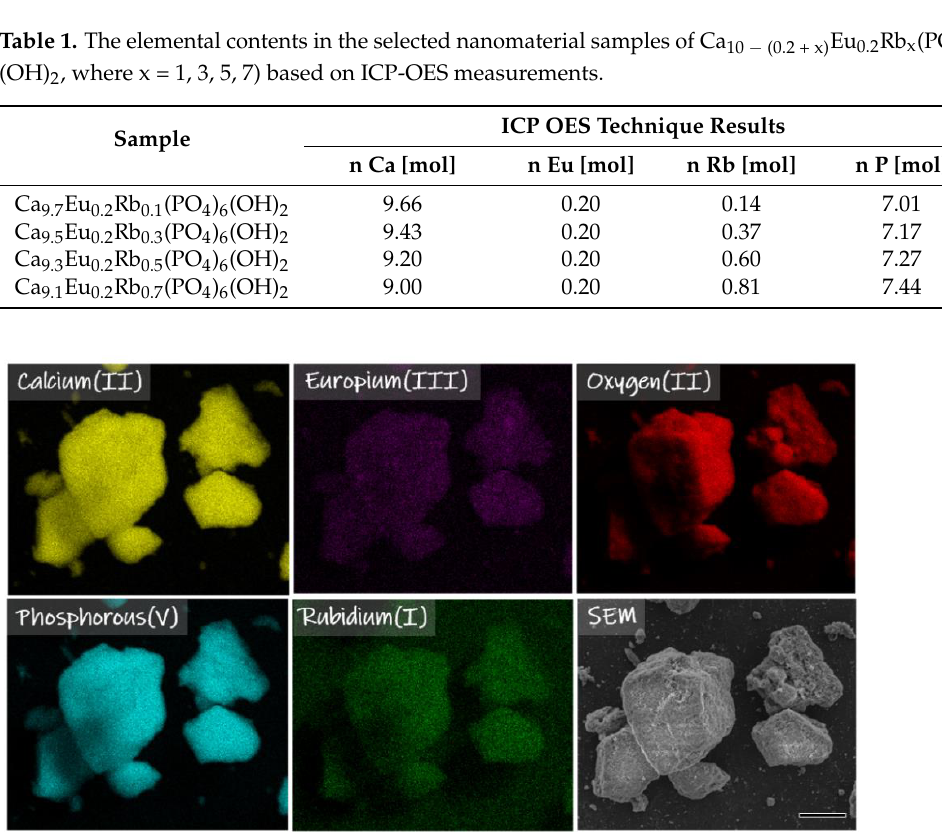
Figure 3. SEM image and SEM-EDS mapping of Ca 9.1 Eu 0.2 Rb 0.7 (PO 4 ) 6 (OH) 2 compound. Images show the elemental composition of the sample which contains calcium, phosphorous, europium, rubidium, and oxygen. Scale bar equals 10 µm.